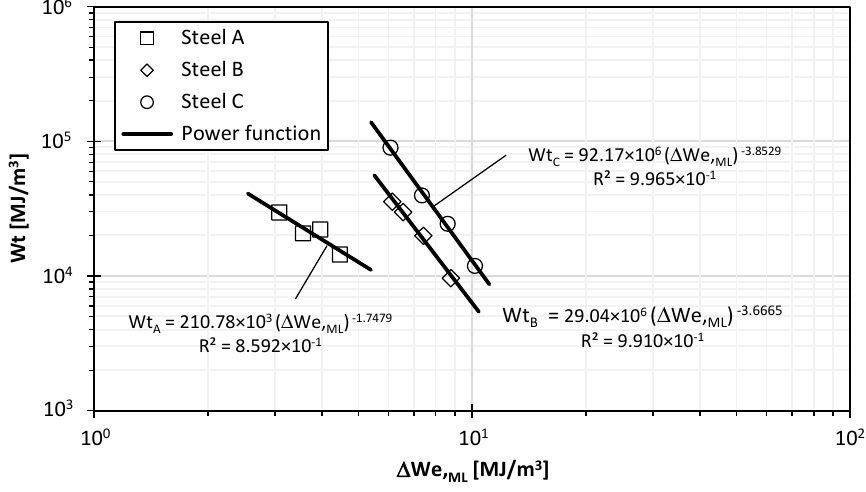
Figure 6. Elastic strain energy density of the mid-life cycle ( ∆ We , ML ) against cumulative total strain energy density (Wt) for the three high-strength bainitic steels under study.